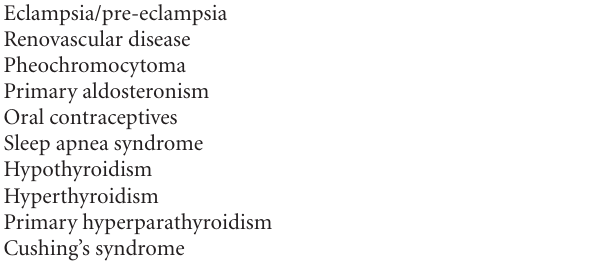
Table 2: Causes of secondary hypertension during